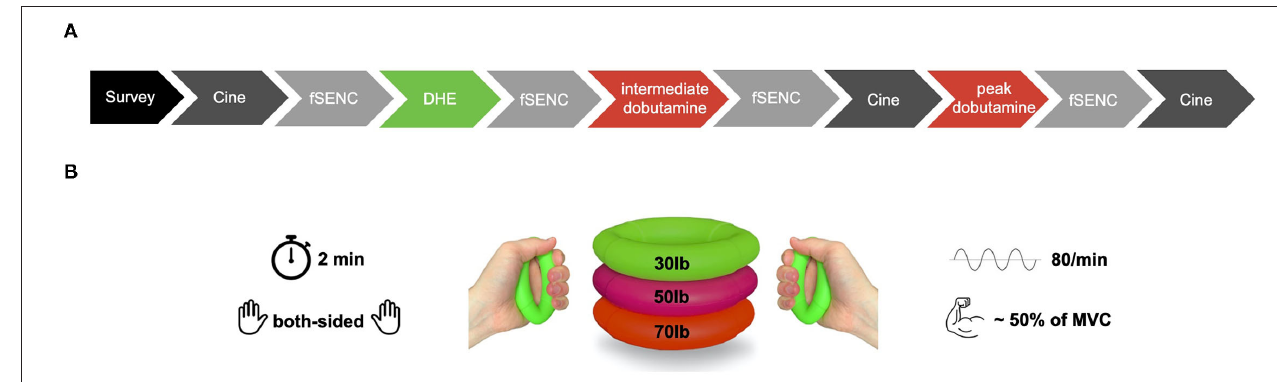
FIGURE 1 | (A) CMR protocol of the DHE study. Additional fSENC-sequences were acquired at rest, after 2min of DHE, and (in the group of patients with CAD) during intermediate (20 µ g/kg body weight/minute) and peak dobutamine/atropine stress (40 µ g/kg body weight/minute + atropine). DHE was performed after all standard sequences at rest and before the start of pharmacological stress. (B) Illustration of DHE. Both-sided, metronome-guided rhythmic hand contractions were performed for 2min at a frequency of 80/min. Handgrip rubber rings at about 50% of maximal voluntary contraction (MVC) were used. CMR, cardiac magnetic resonance imaging; fSENC, fast strain-encoded magnetic resonance imaging; DHE, dynamic handgrip exercise; CAD, coronary artery disease; MVC, maximal voluntary contraction.